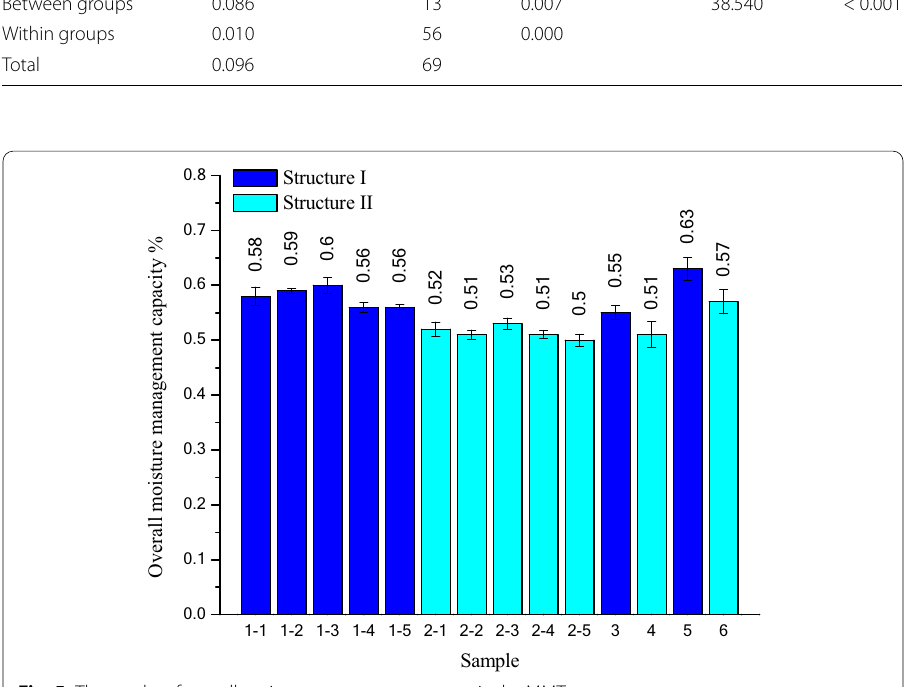
Fig. 5 The results of overall moisture management capacity by MMT